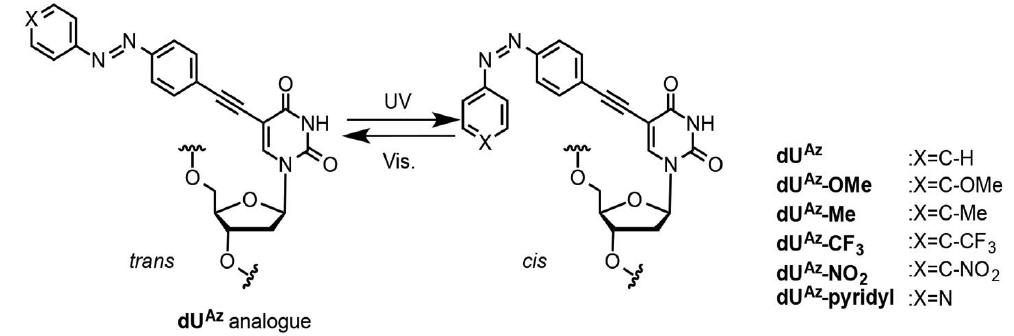
Figure 1. Para -substituted dU Az analogues used in this